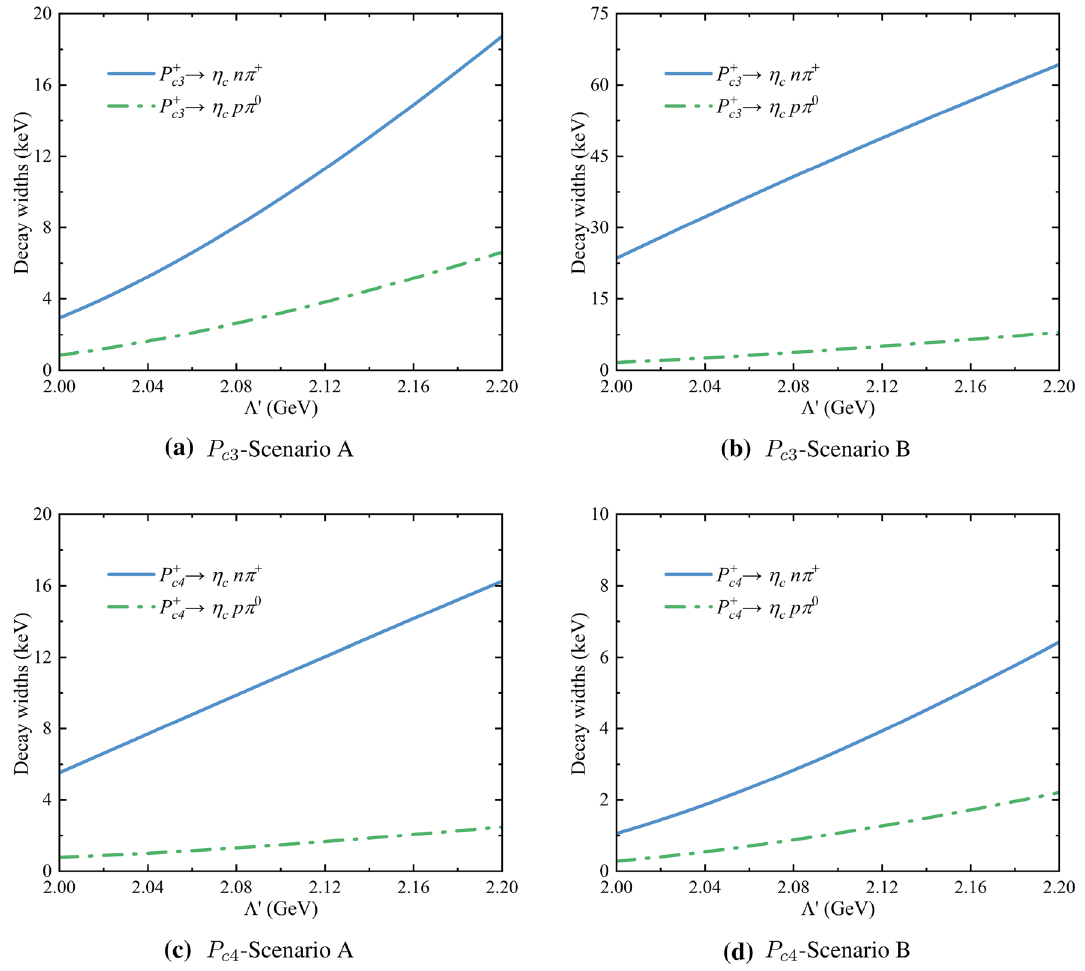
→ η π + and P + → η π 0 as a function of the cutoff (cid:4) (cid:9) in the form factors (A15). The results are c n c p c 3 | c 4 c 3 | c 4